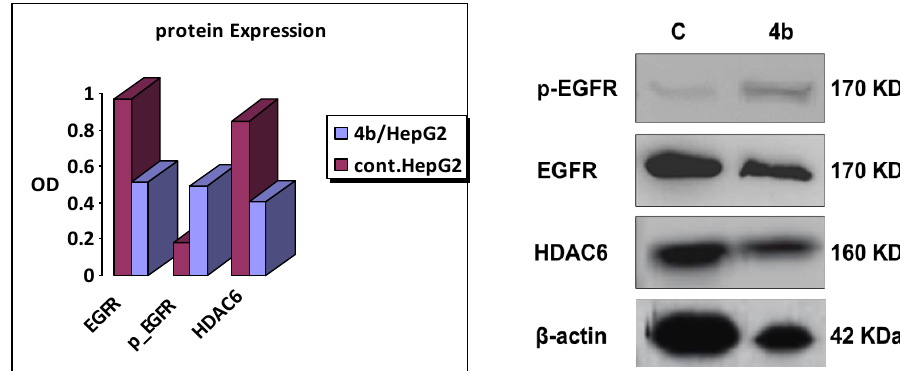
Figure 4. Western blot analysis of 4b on EGFR and HDAC6 in HepG2 cancer cell line.